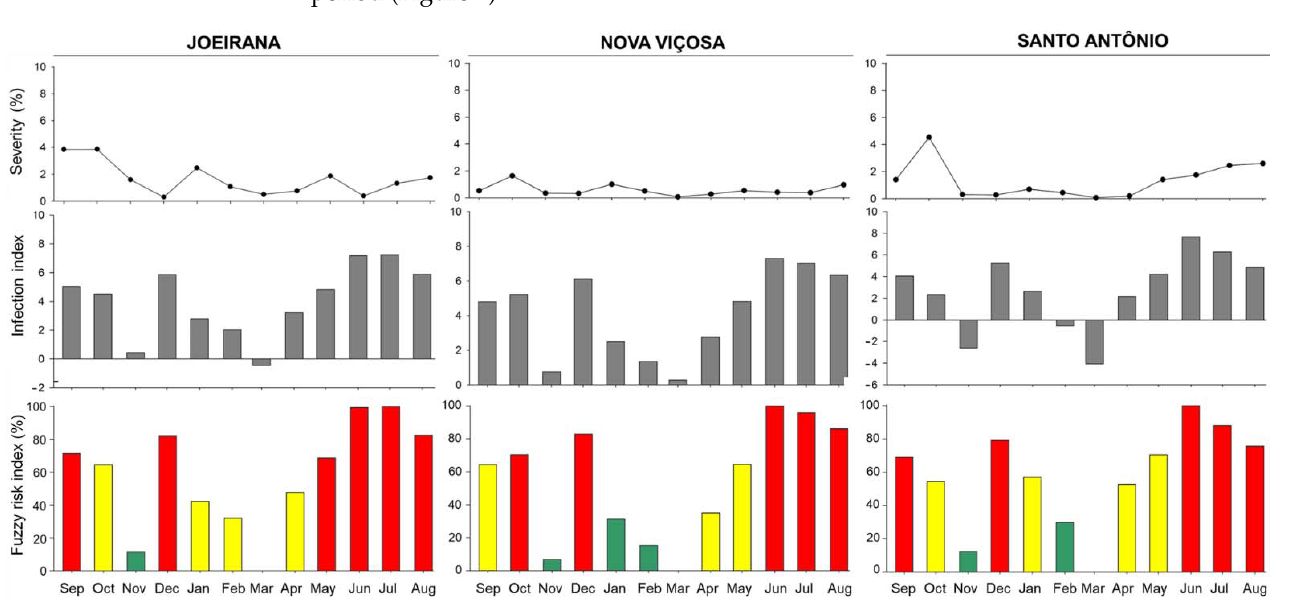
Figure 7. Severity of eucalyptus rust (%), infection index according to the equation of [11], and fuzzy risk index for the period from October 2008 to August 2009, under field conditions, in the municipalities of Joeirana, Nova Viçosa, and Santo Antônio, located in the extreme south of Bahia,